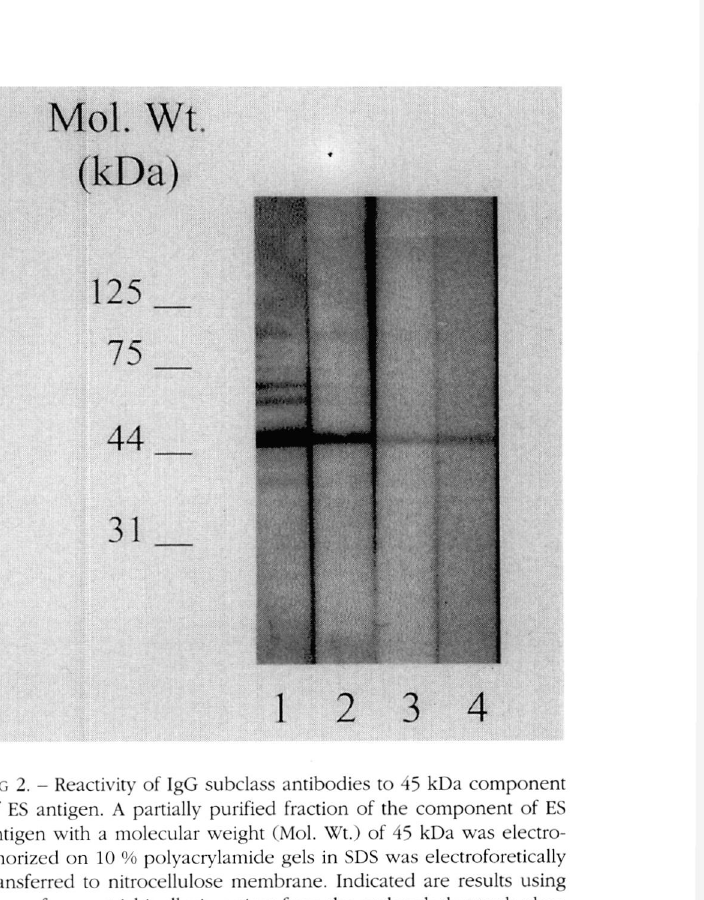
FIG 2. - Reactivity of IgG subclass antibodies to 45 kDa component of ES antigen. A partially purified fraction of the component of ES antigen with a molecular weight (Mol. Wt.) of 45 kDa was electro- phorized on 10 % polyacrylamide gels in SDS was electroforetically transferred to nitrocellulose membrane. Indicated are results using scrum from a trichinellosis patient from the outbreak that took place in Poland in 1991; IgGl (lane 1), IgG2 (lane 2), IgG3 (lane 3) and IgG4 (lane